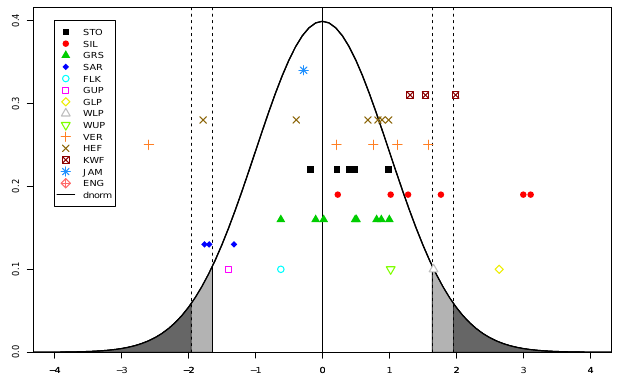
Fig. 4. Reduced discrepancies between all of the analysed periods of record. The reduced discrepancy (horizontal axis) has no unit and the values for the different glaciers are arbitrarily distributed along the vertical axis for a better overview. The curve labelled ‘dnorm’ denotes the probability density function for the standard (zero- mean, unit-variance) normal distribution. Shaded areas in dark and light grey indicate 95% and 90% confidence levels, respectively. The values for ENG are all > 4 and, hence, not